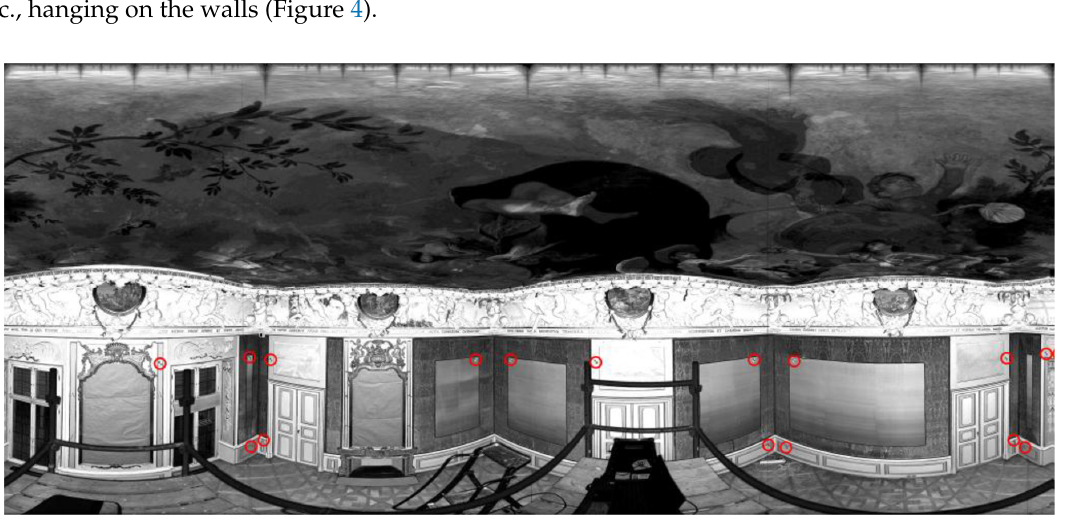
Figure 4. The point cloud in the spherical projection of test site I: “The Queen’s Bedroom” with marked points (red circles).